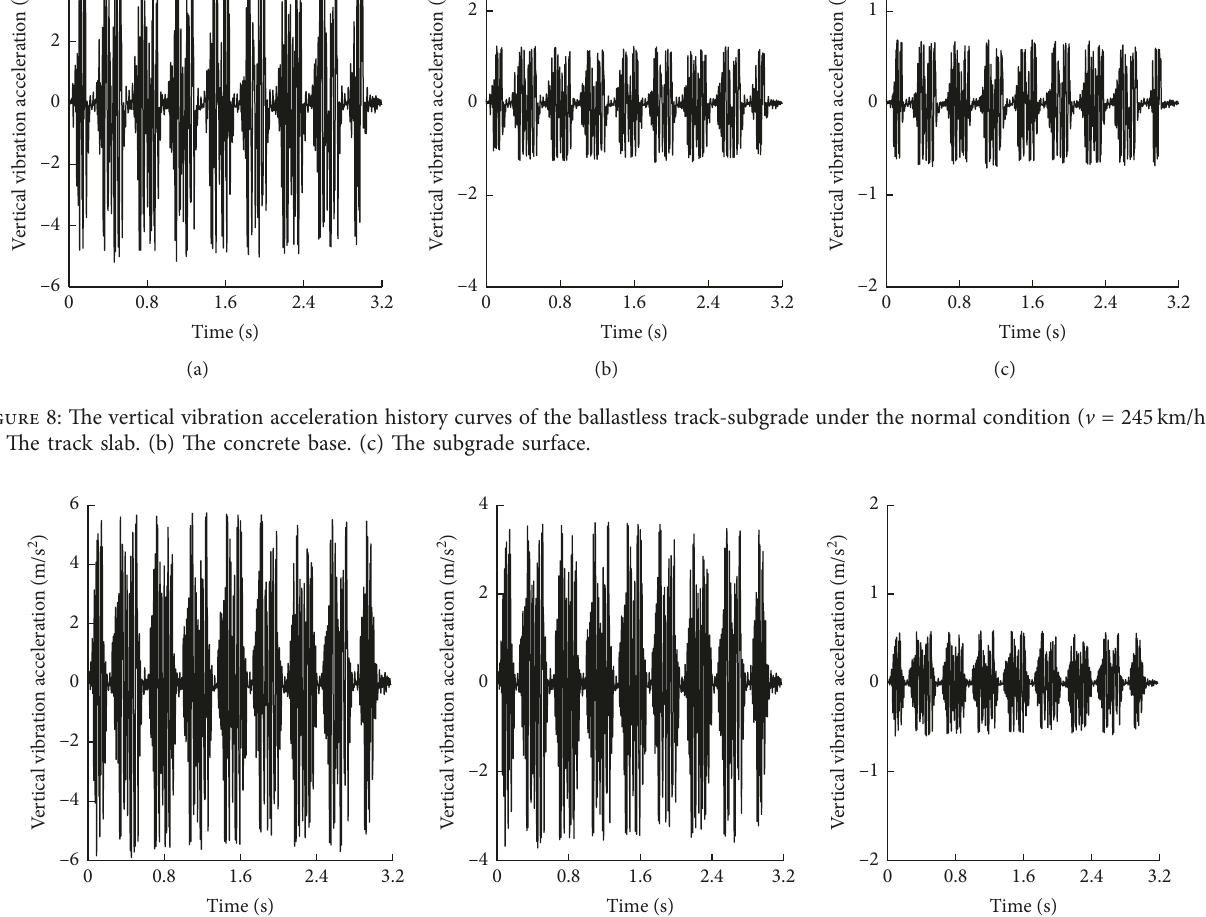
245km/h). (a) The track (cid:31)